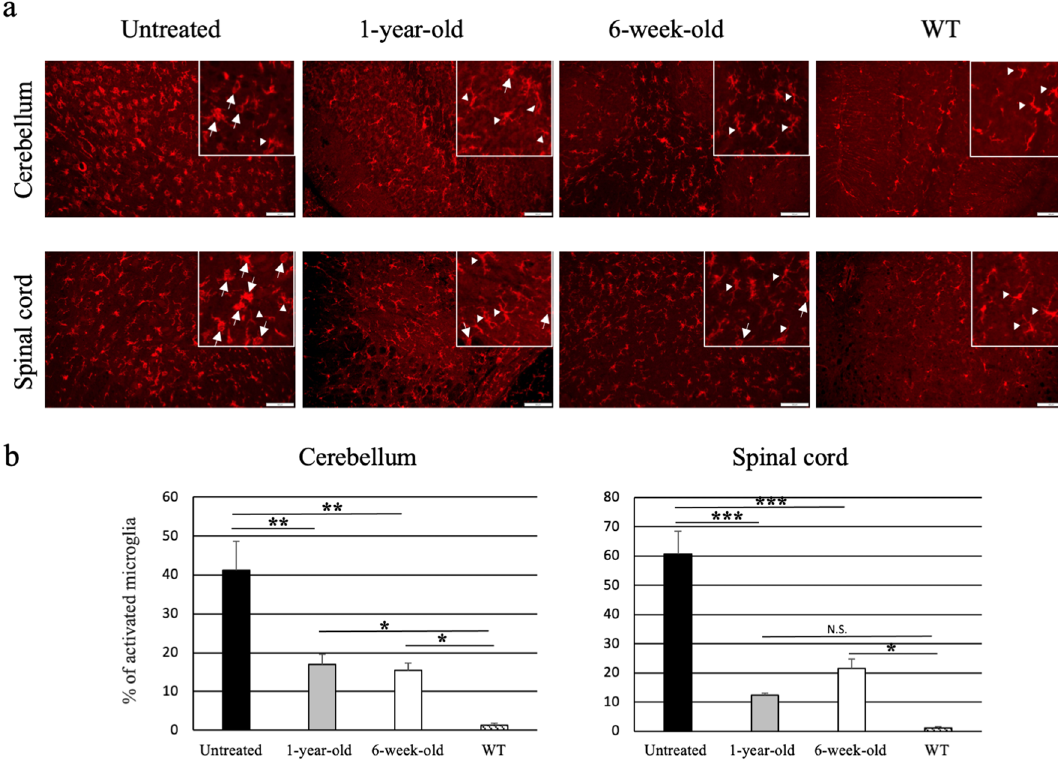
Figure 5. Reduction of activated microglia in AAV9/ARSA-treated MLD mice. ( a ) Immunostaining for the microglia marker Iba1 in the cerebellum and spinal cord. ( b ) Fifteen-month-old untreated mice showed amoeboid microglia cells (arrows), which correspond to activated microglia. MLD mice treated with AAV9/ ARSA at 1 year or 6 weeks of age and wild-type (WT) mice showed ramified microglia (arrow heads), which correspond to non-activated microglia. % of activated microglia was calculated as (number of activated microglia/ numbers of Iba1 positive cells). All calculations were done on random three fields of each mouse (untreated: n = 3, 1 year treated: n = 3, 6 week treated: n = 3, and WT: n = 3) Bar: 100 μM. *p < 0.05, **p < 0.01, ***p <